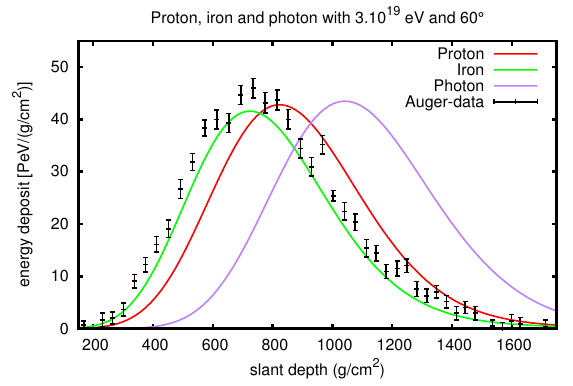
Figure 7. Average number of fluorescence photons between 329- 428 nm recorded by an ideal detector aboard the ISS as a function of time (1 GTU = 2 . 5 µ s). The primary particles are proton, iron and photon with E = 100 EeV and θ = 60 ◦ . For each primary particle, 500 events were